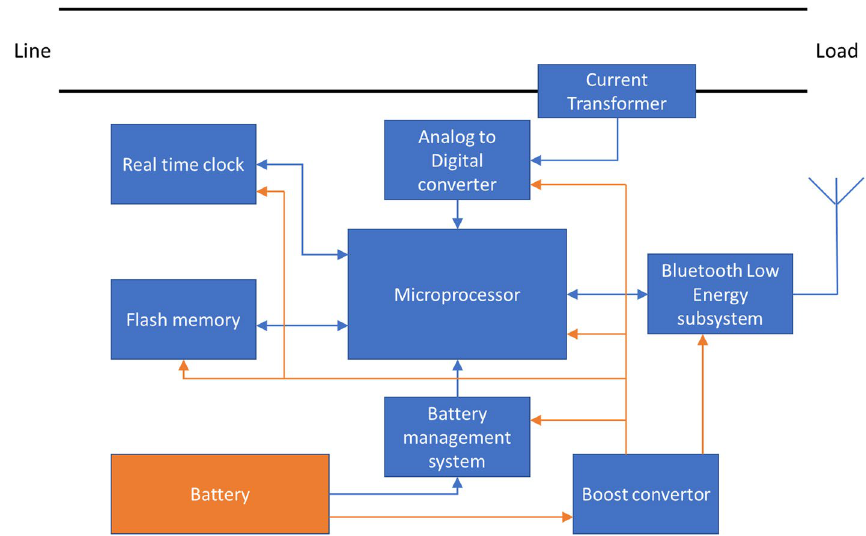
Fig. 3 Block diagram of the Garud hardware module blue lines indicate data connections and orange lines indicate power supply (Ministry of Housing and Urban Affairs, Government of India